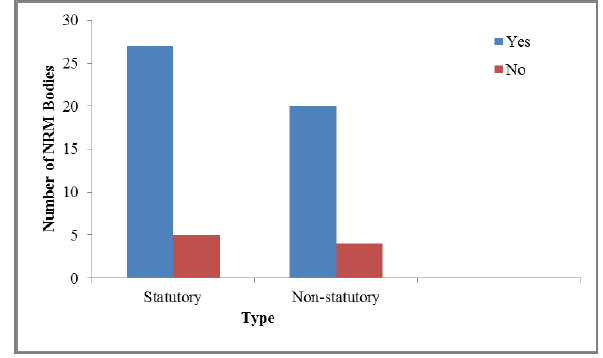
Figure 5: Collaborative arrangements